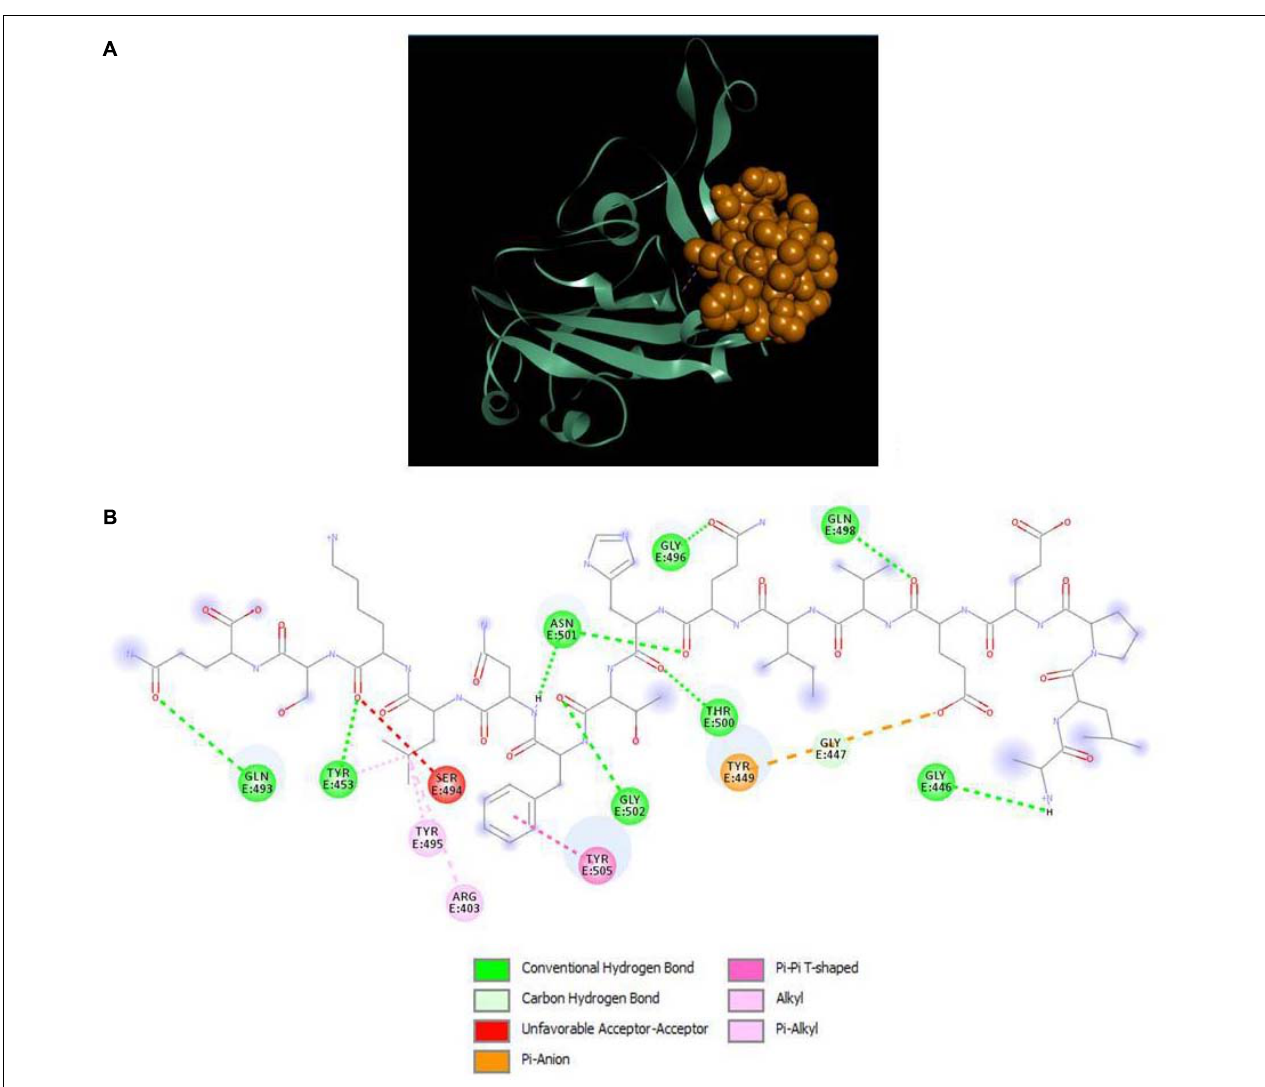
FIGURE 2 | (A) Docking of RBD (ribbon) and peptide P13 (CPK), (B) 2D representation of RBD-peptide interactions. GLN493 and ASN501 are designated as critical to RBD-hACE2